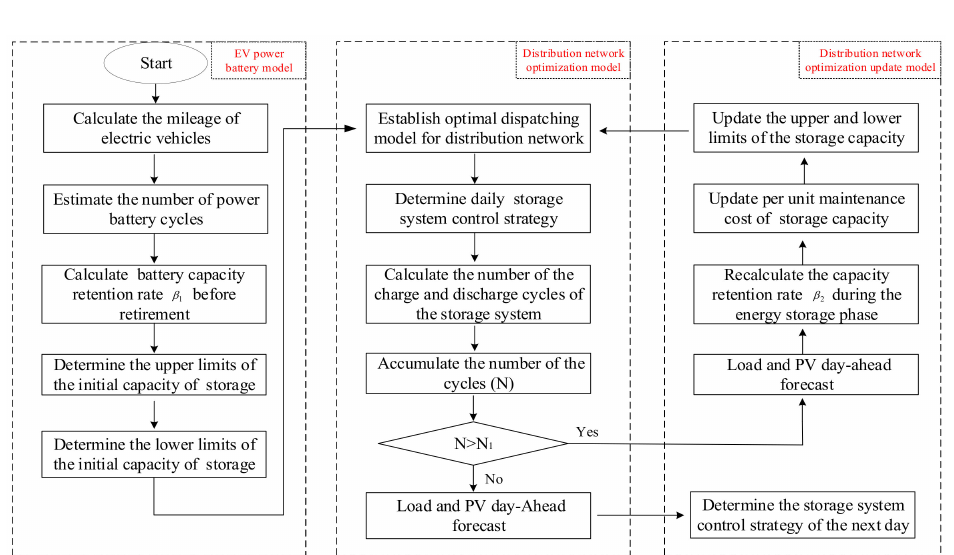
Figure 4. The framework of SUESS embedded distribution system scheduling